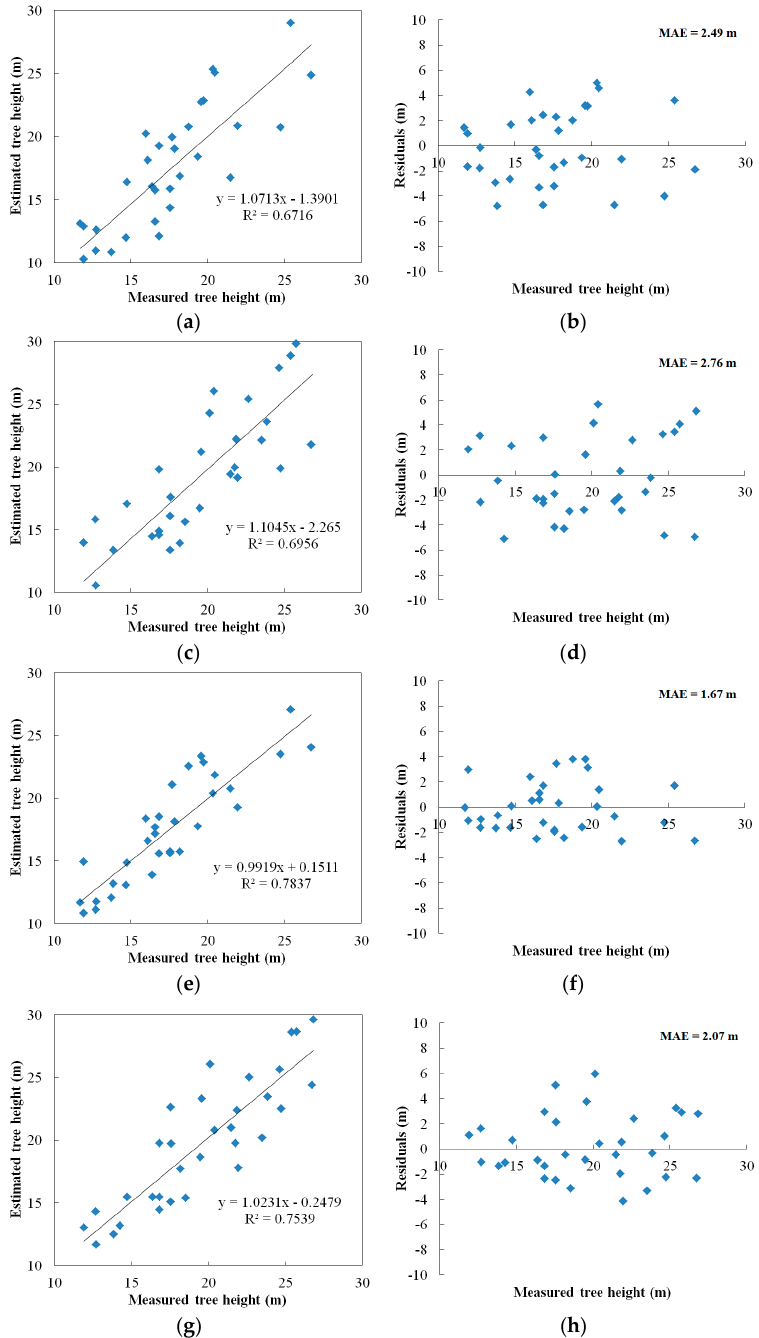
Figure 10. Comparisons of linear regression models and residual plots obtained from the two other methods. ( a ) and ( c ) are the linear regression models through the method based on point cloud automatic classification of Plantations 1 and 2, respectively; the corresponding residual plots are ( b ) and ( d ). ( e ) and ( g ) are the linear regression models through the proposed method without the contour-surround constraint of Plantations 1 and 2, correspondingly; the corresponding residual plots are ( f ) and ( h ). Table 5. Comparison of the t -test values of the three methods for the two forest plantations. ① denotes the method based on point cloud automatic classification, ② denotes the proposed method without the contour-surround constraint.